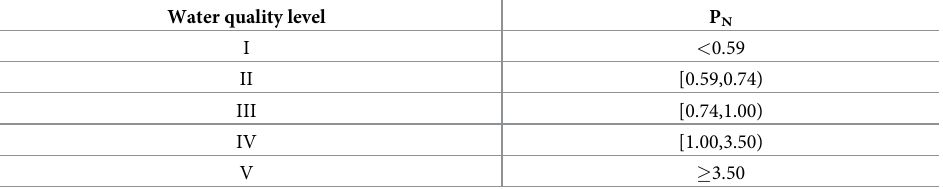
Table 2. Water quality level determination based on the Nemerow pollution index method.